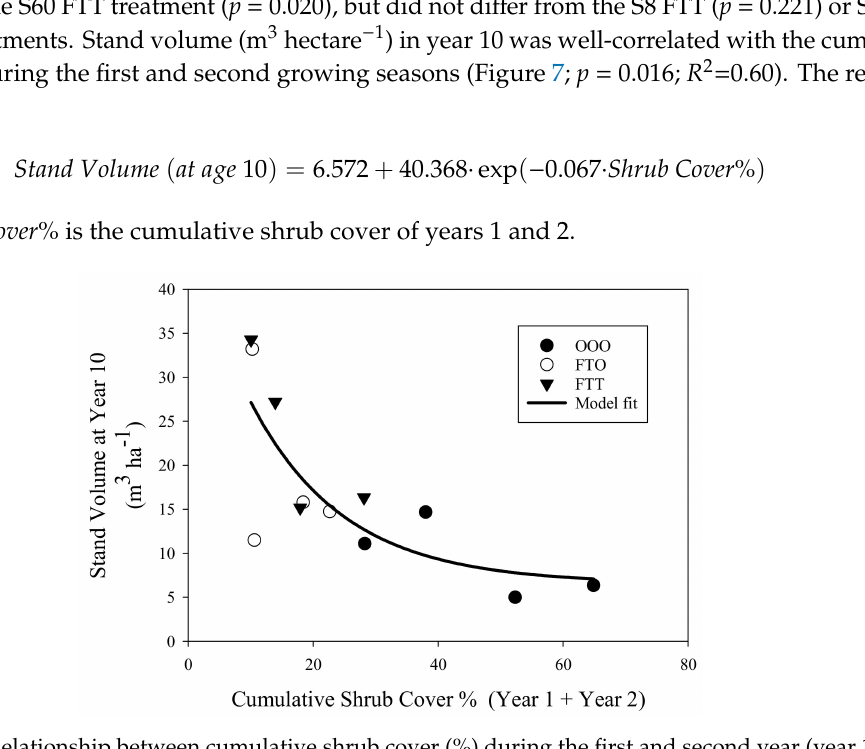
Figure 7. Relationship between cumulative shrub cover (%) during the first and second year (year 1 + year 2) and year 10 stand volume of Douglas-fir. Treatment descriptions are provided in Table